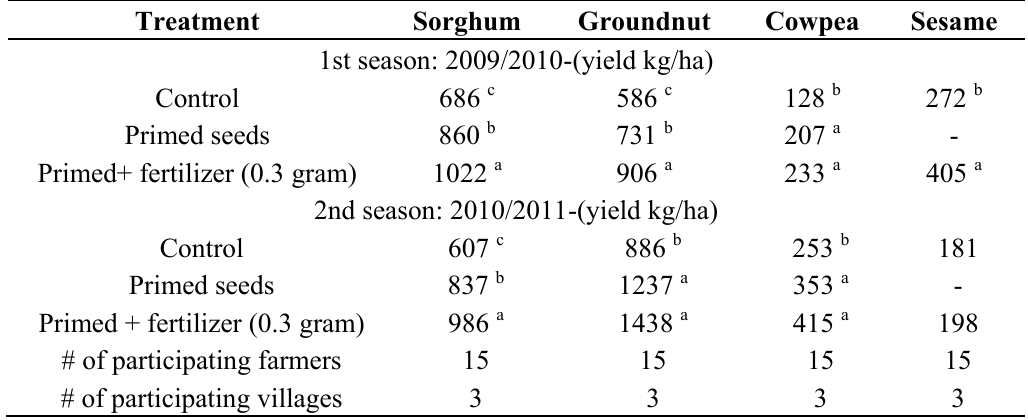
Table 10. On-farm evaluation of seed priming and fertilizer micro-dosing at three villages (15 farmers from each village) in South Kordofan.